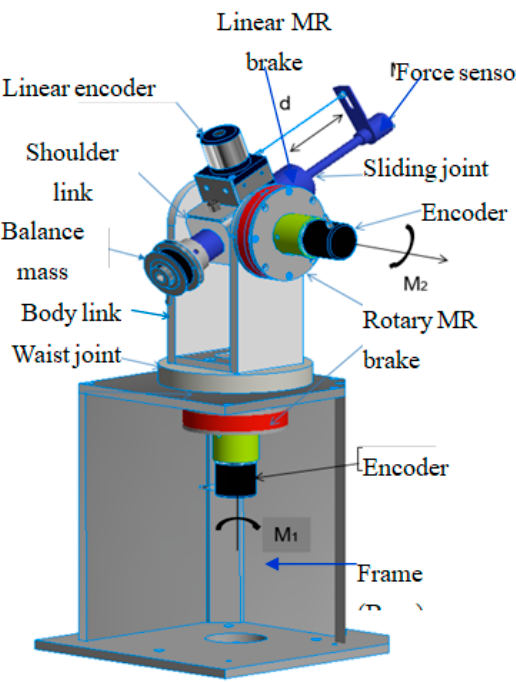
Figure 1. Configuration of the 3-DOF spherical force feedback system.